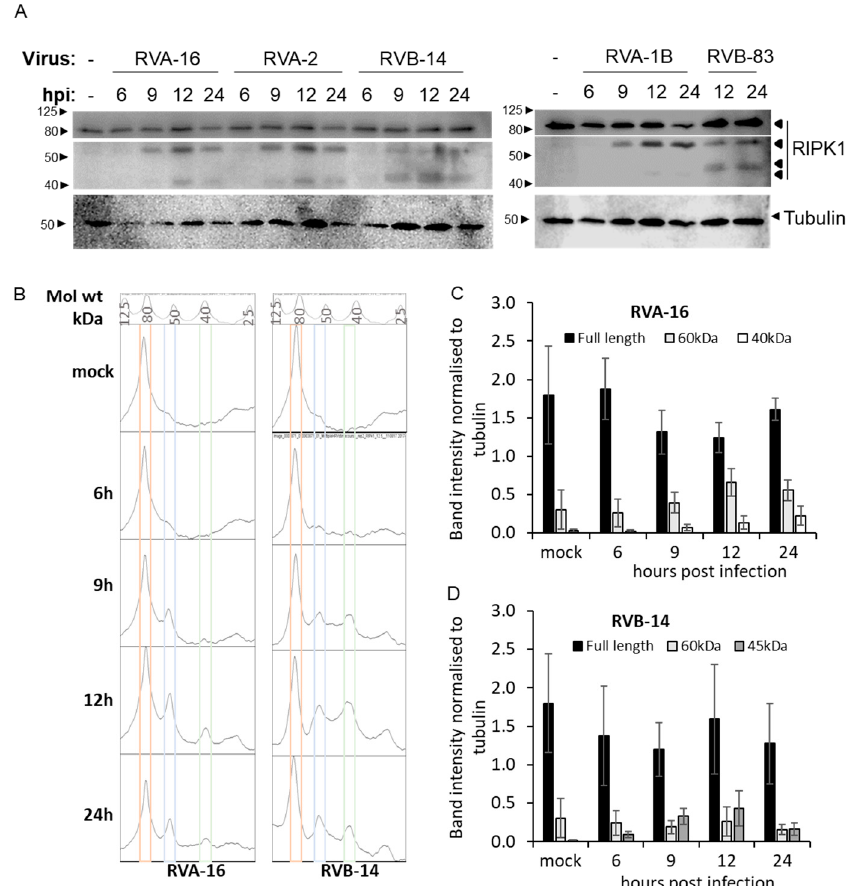
Figure 1. Infection with different RVs results in RIPK1 cleavage. O-HeLa cells were infected with the RV strains indicated at an M.O.I. of 3, for 1 h of adsorption, then cultured for a further 24 h post-infection (hpi). Protein lysates were collected at the indicated times and subject to SDS-PAGE (12.5%), transferred to nitrocellulose membrane and blocked. ( A ) Blots were probed with anti-RIPK1 antibodies. Tubulin was used as a loading control for all blots and is included below the corresponding RIPK1 blots. The position of bands correlating to the indicated full-length protein, or the cleavage products are indicated to the right of the blot. The relevant molecular weights are indicated to the left of the blots. The blots shown are representative of three repeats. ( B ) ImageJ was used to plot the densitometric profile of each of the lanes in the blot; each peak corresponds to a band in the blot. Profile of the molecular weight marker lane and the size corresponding to each peak is shown at the top. Coloured boxes indicate peaks corresponding to RIPK1 bands. ( C , D ) Intensity of RIPK1 bands was measured with ImageJ and normalized to the corresponding tubulin band. Data shown are mean ± SEM of three